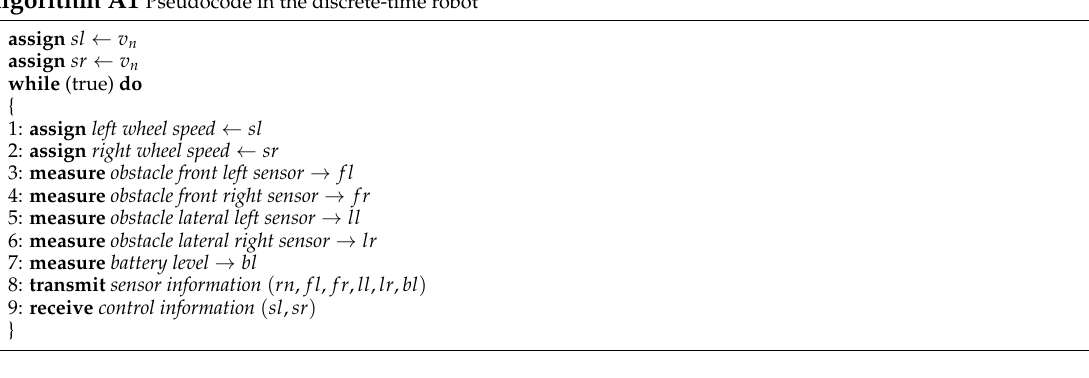
Algorithm A1 Pseudocode in the discrete-time robot